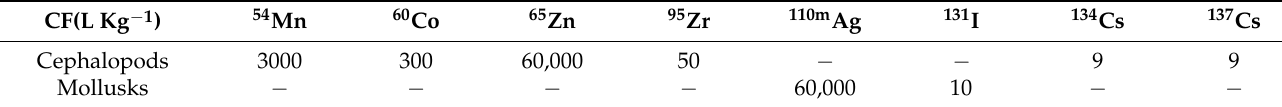
Table 4. The CFs of Cephalopods and Mollusks